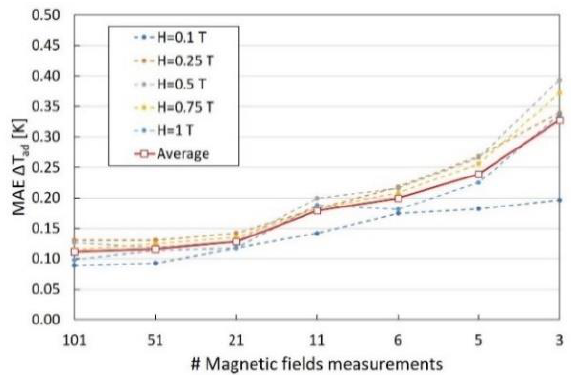
Figure 2. Mean absolute error of the adiabatic temperature change predictions with different sizes of the training set at different magnetic fields. The number of temperature samples considered during the training of the ANNs has been fixed at 11.